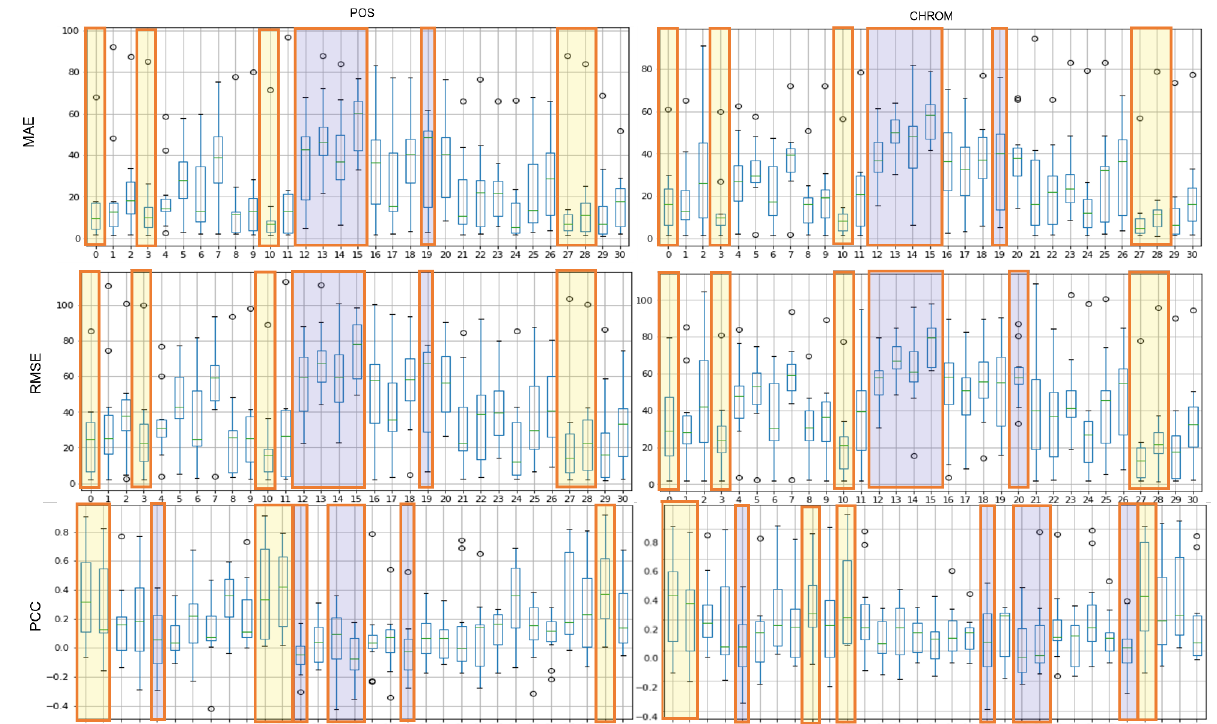
Figure 7. Performance evaluation of proposed ROIs on UBFC data (yellow: TOP-5, blue: BOT-5). Figure 8 shows the results of the MAE, RMSE, and PCC metrics on LGI-PPGI data. Regions 0, 10, and 27 are commonly included in TOP-5 in the whole metrics. Regions 0 and 10 were found to be the best regions in both datasets.